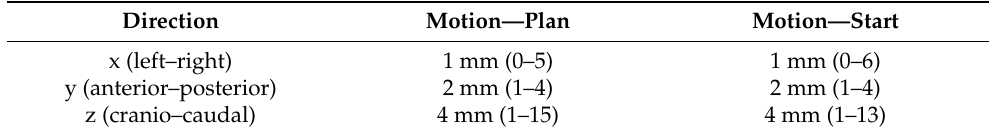
Table A3. Breathing motion amplitudes of the primary tumor in the Plan and Start 4DCTs. Median value and range are given for each direction.